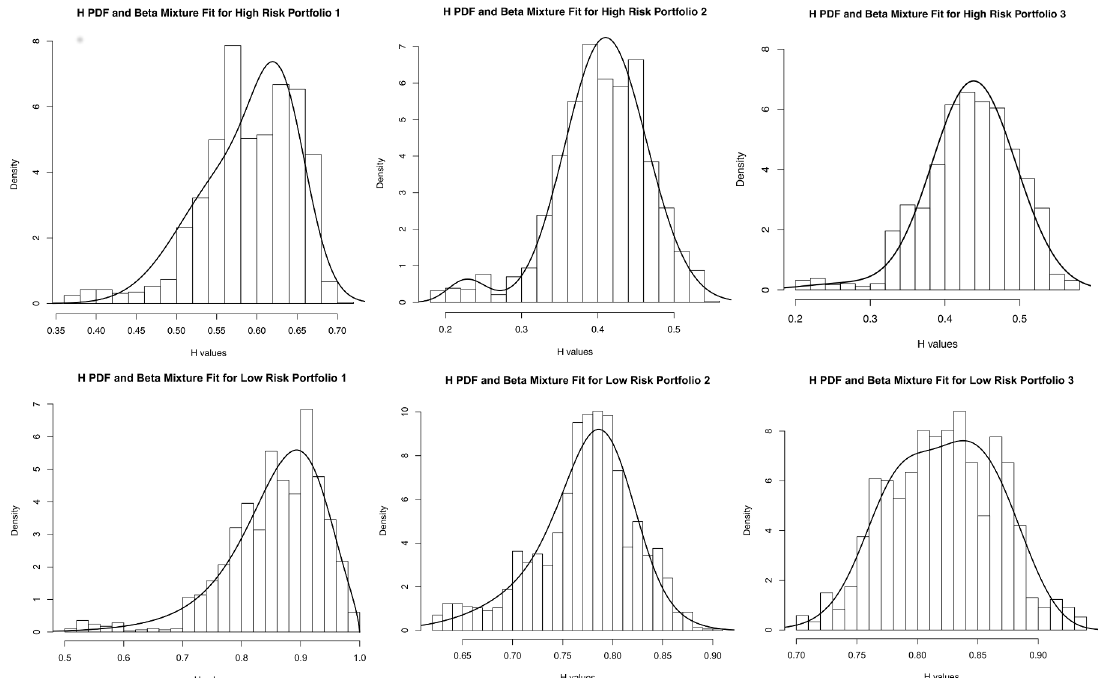
Fig 4. Mixture of beta distribution fit to the Hölder exponent of different portfolios. First row: mixture of beta fitting of H of high risk portfolios (HRP1, HRP2, HRP3). Second row: mixture of beta fitting of H of low risk portfolios (LRP1, LRP2, LRP3).